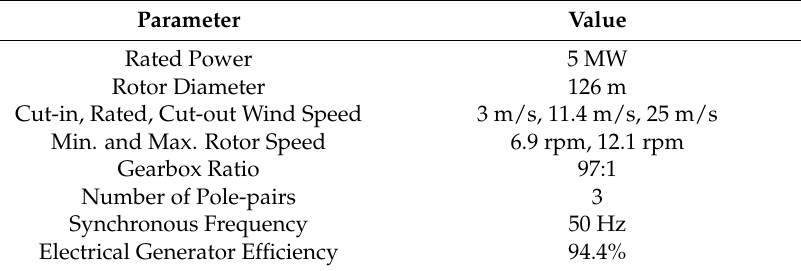
Table 1. Parameters of NREL 5 MW wind turbine